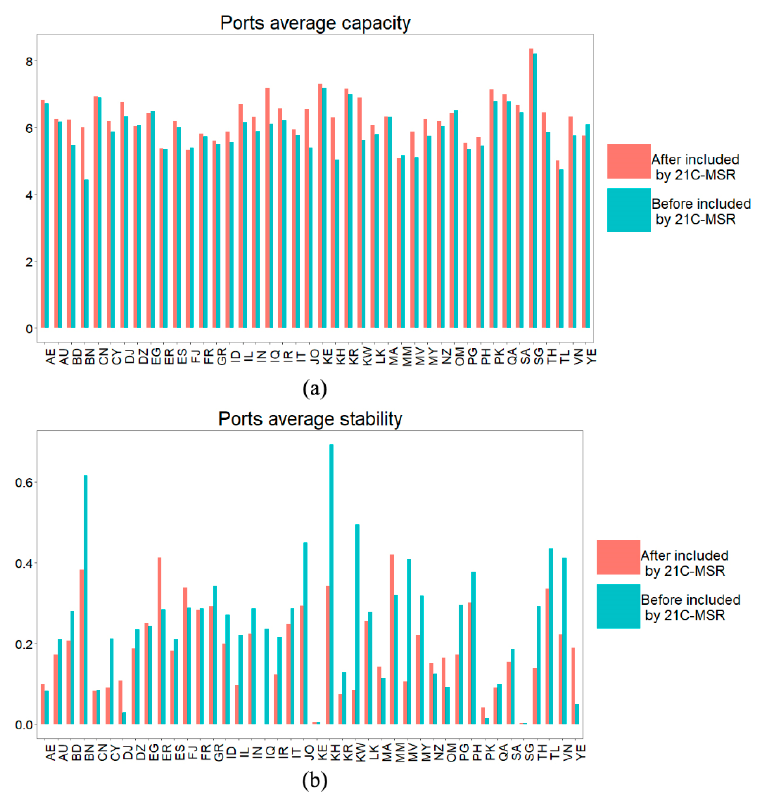
Figure 7. Ports average capacity and stability before and after included by 21C-MSR; ( a ) Port average capacity and ( b ) port average stability.